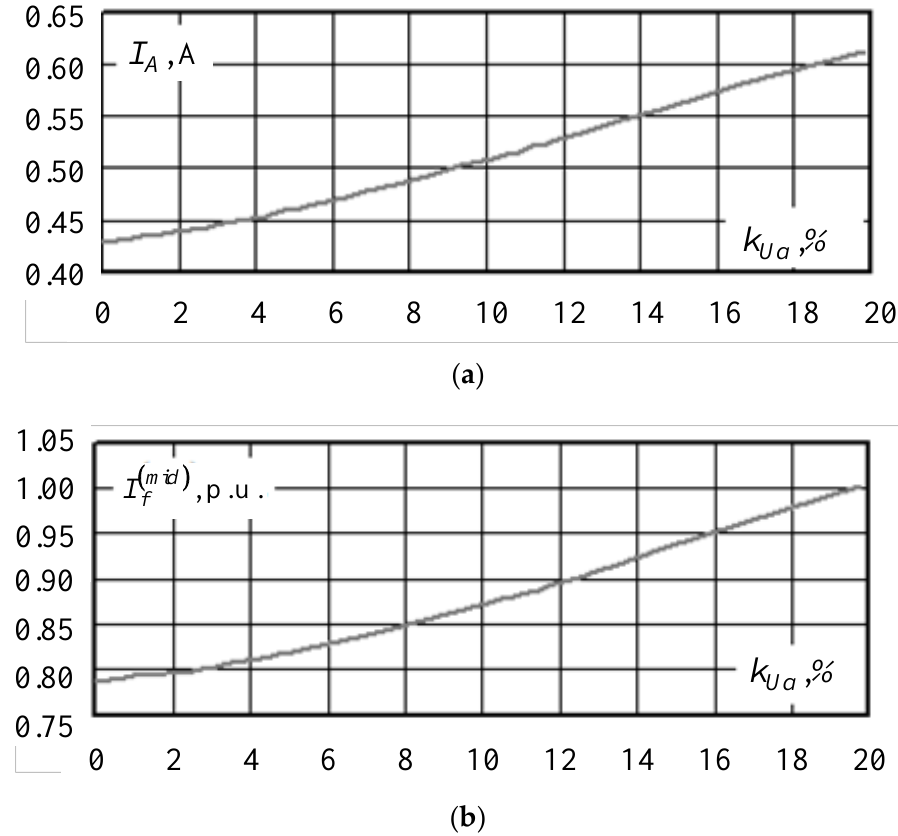
Figure 9. Stator current ( a ) and rotor current ( b ) of the generator as a function of the deviation of the voltage waveform from the sine waveform.